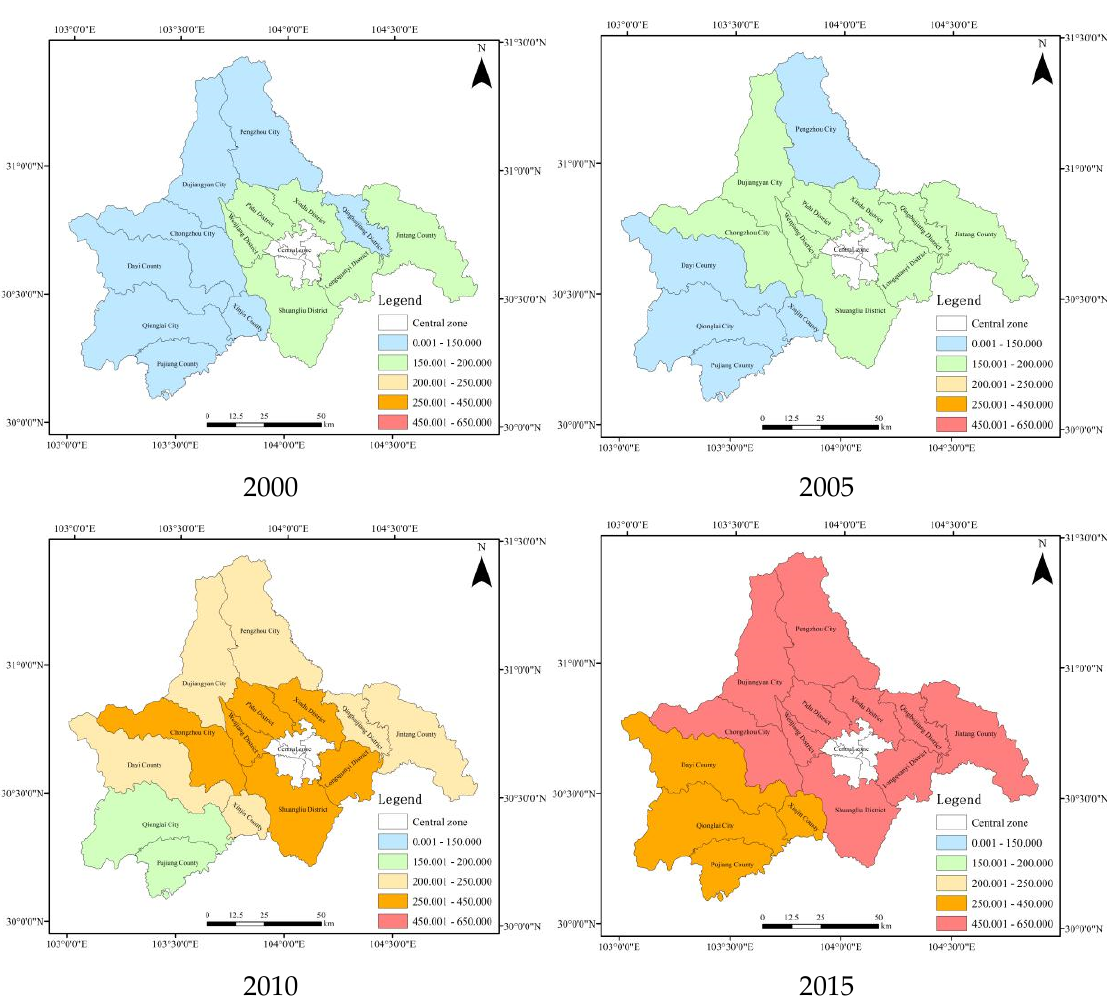
Figure 9. The change of URI level from 2000 to 2015.